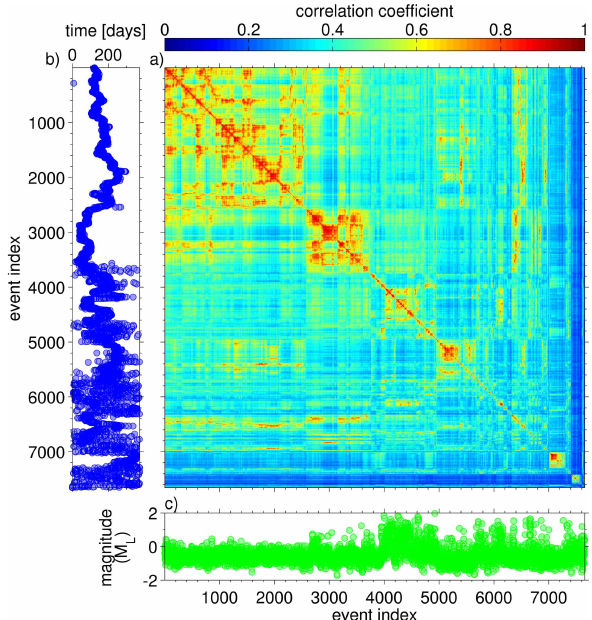
Fig. 6. Sorted network similarity matrix with associated event clus- ters found by visual inspection. Clusters finally identified are indi- cated by the bright colours close to the diagonal of the SM. The largest clusters correspond to those shown in Fig.